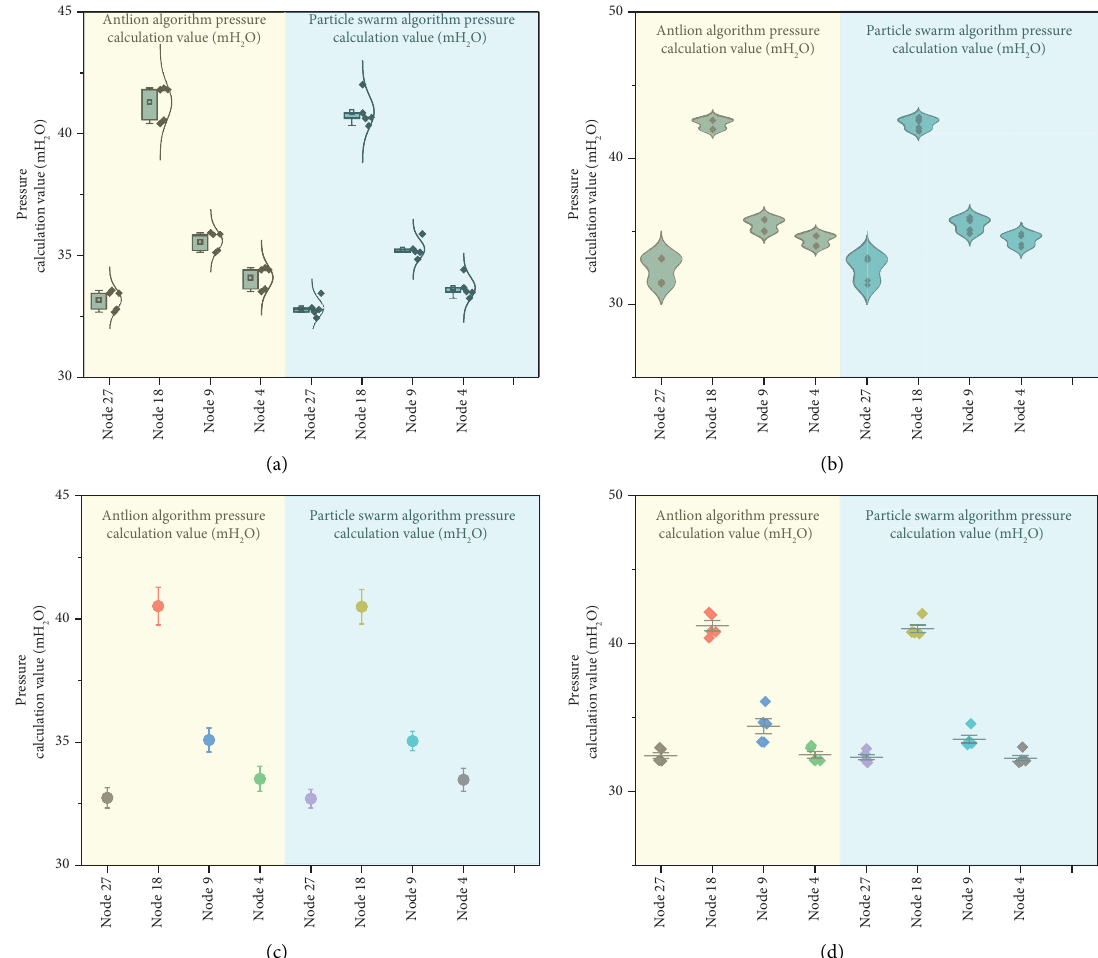
Antlion algorithm pressure calculation value (mH 2 O)